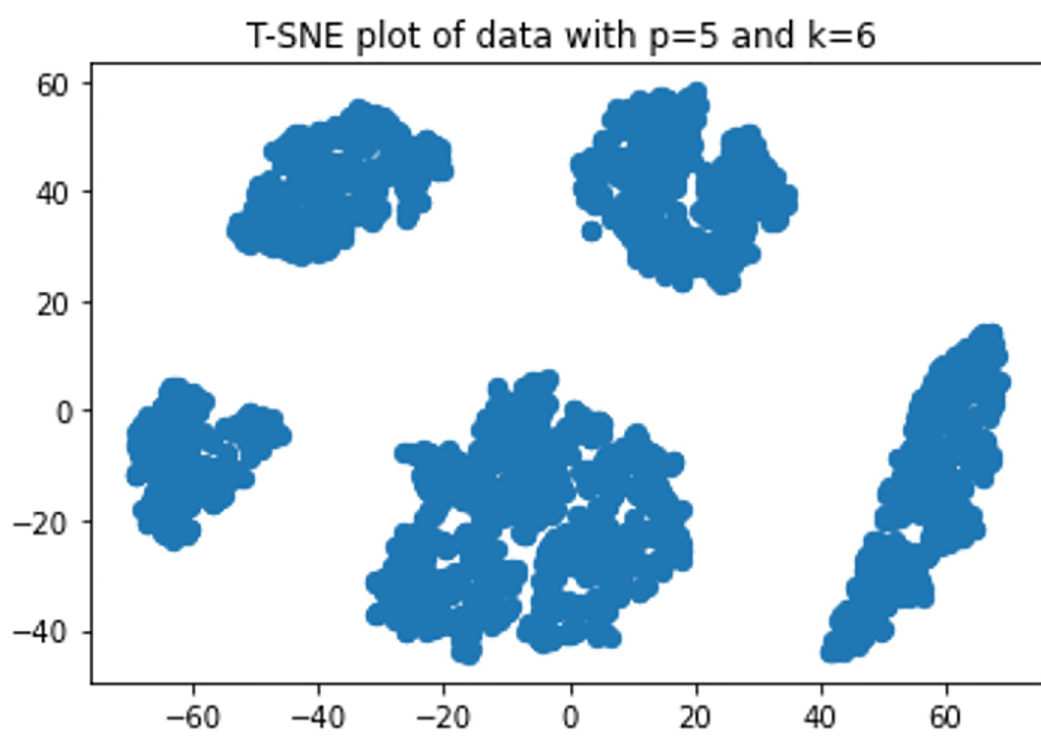
Fig 7. T-SNE plot of data with p = 5 and k =